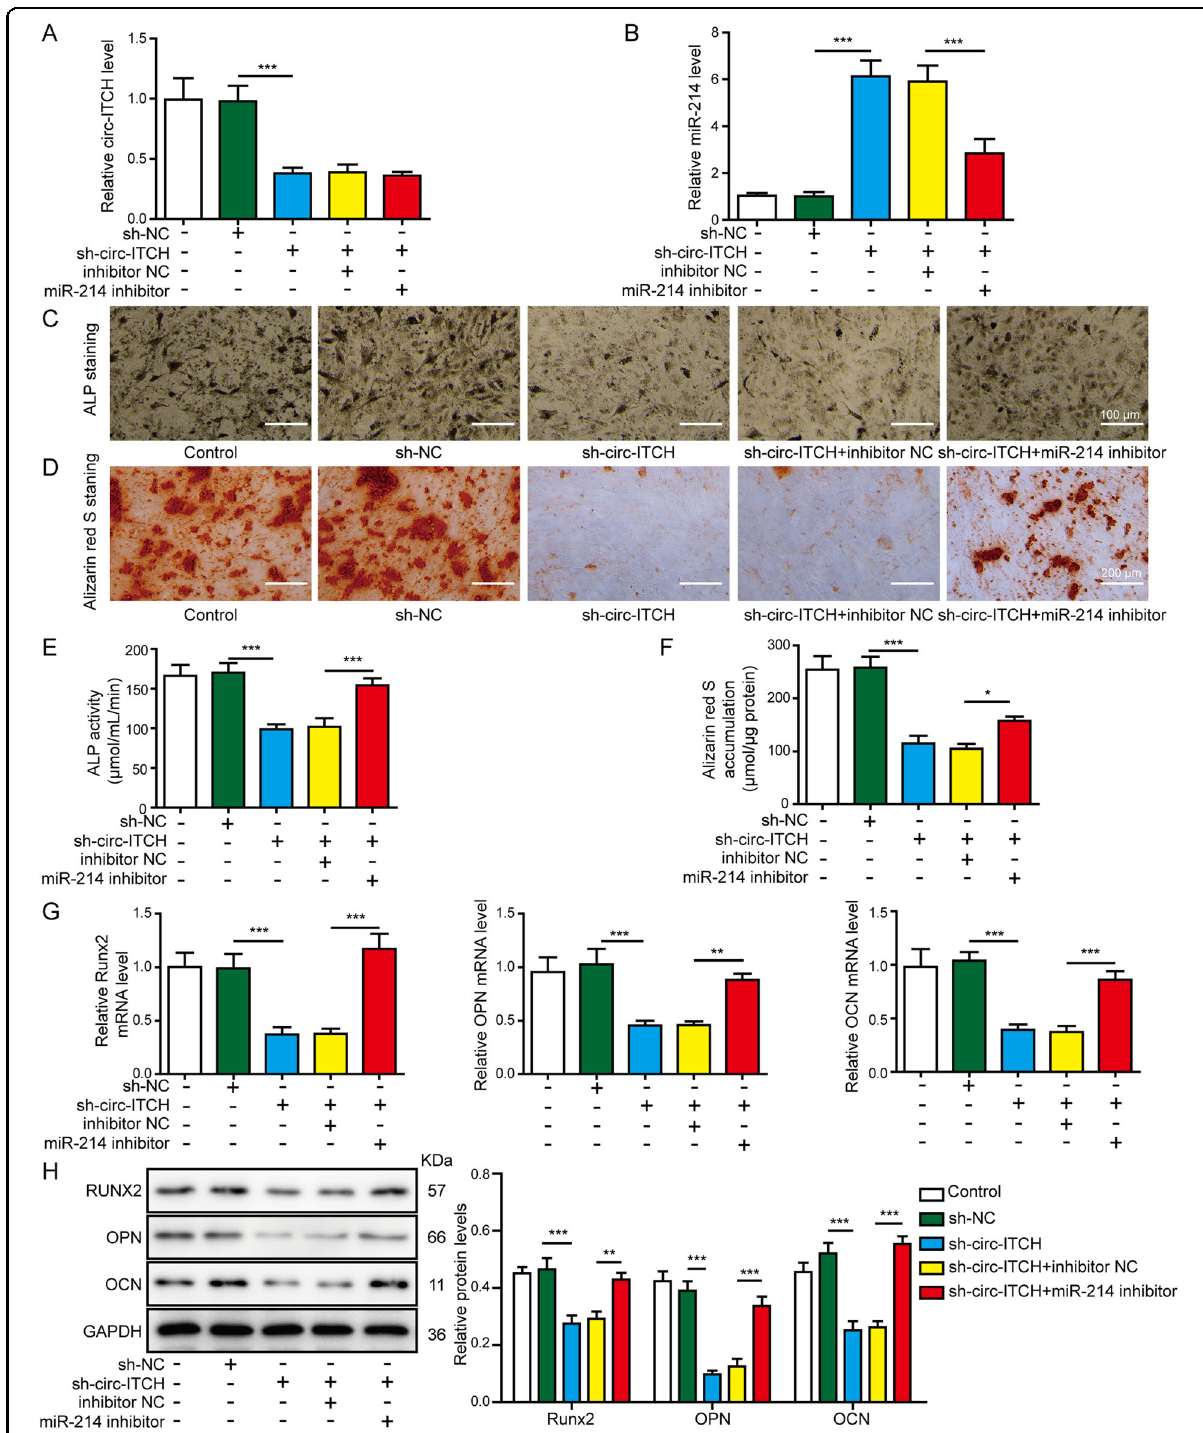
Fig. 4 MiR-214 knockdown reversed the effects of circ-ITCH inhibition on osteogenic differentiation of hBMSCs. The hBMSCs were transfected with sh-circ-IITCH alone or co-transfected with sh-circ-IITCH and miR-214 inhibitor. A , B RT-qPCR analyses of circ-ITCH and miR-214 expression in hBMSCs. C ALP staining was performed on day 14 after osteogenic differentiation. Scale bar: 100 μ m. D Alizarin red S staining was performed on day 14 after osteogenic differentiation. Scale bar: 200 μ m. E ALP activity detection was performed on day 14 after osteogenic differentiation. F Alizarin red S accumulation detection was performed on day 14 after osteogenic differentiation. G , H The mRNA and protein expression levels of RUNX2, OPN, and OCN were assessed by RT-qPCR and western blot assays on day 14 after osteogenic differentiation. * P < 0.05, ** P < 0.01, and *** P <